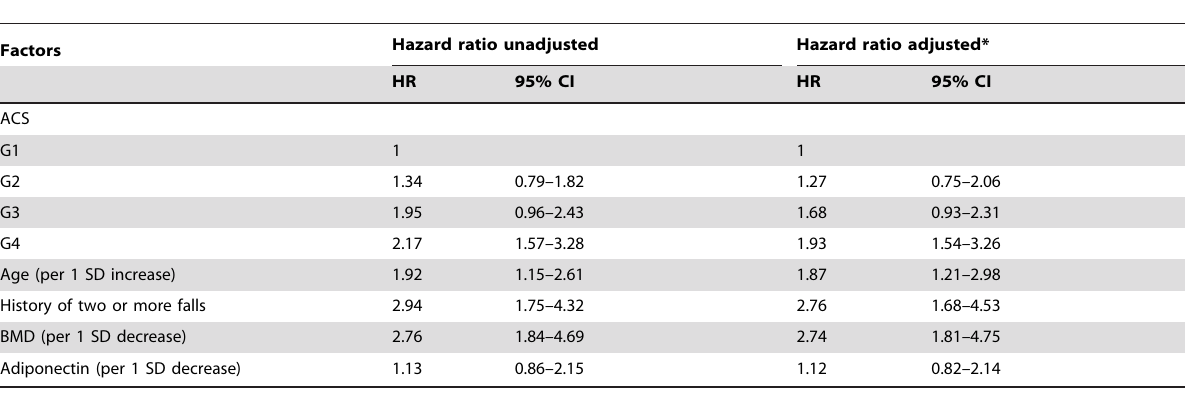
Table 4. Association between AC and non-vertebral fractures in Cox proportional hazard regression